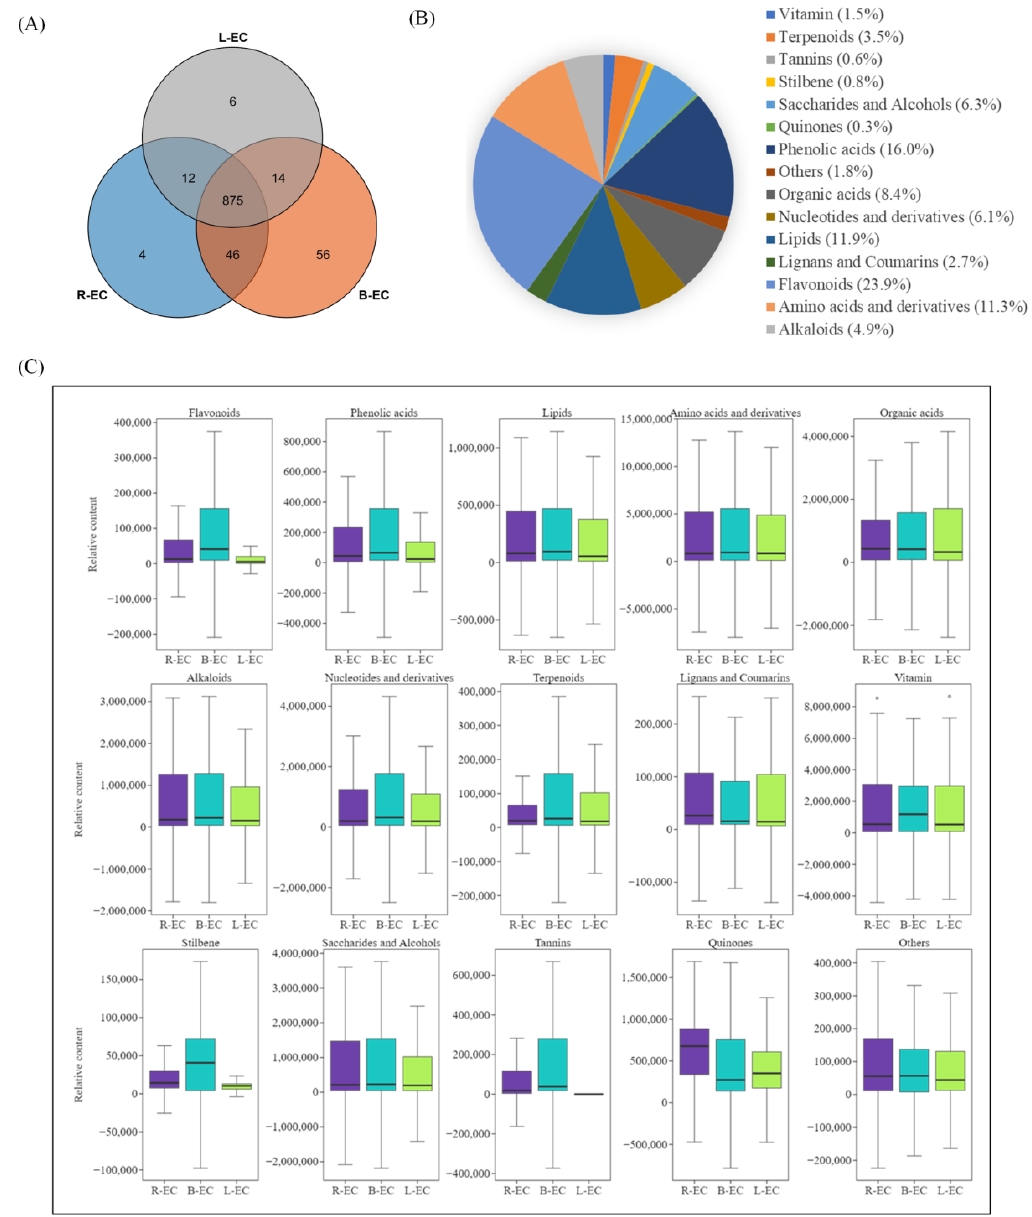
Figure 6. Metabolomic analysis of Korean pine R-EC, B-EC, and L-EC cell lines. ( A ) Quantita- tive statistics of metabolites among R-EC, B-EC, and L-EC. ( B ) R-EC, B-EC, and L-EC metabolite classification. ( C ) Variability of different metabolite classes in R-EC, B-EC, and